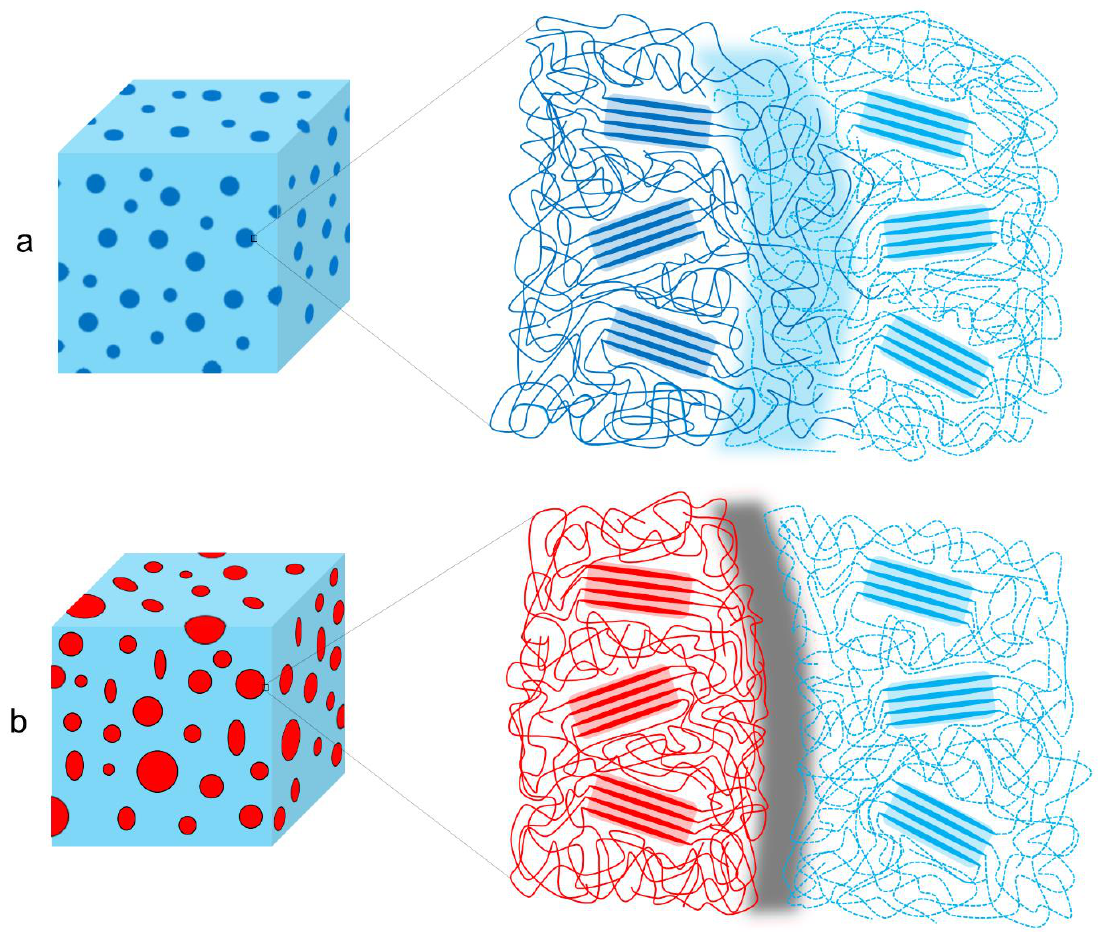
Figure 4. Miscibility at the polymer blend interphase: ( a ) compatible polymer blends with a mixed amorphous interphase and ( b ) immiscible polymer blends with clear phase separation.